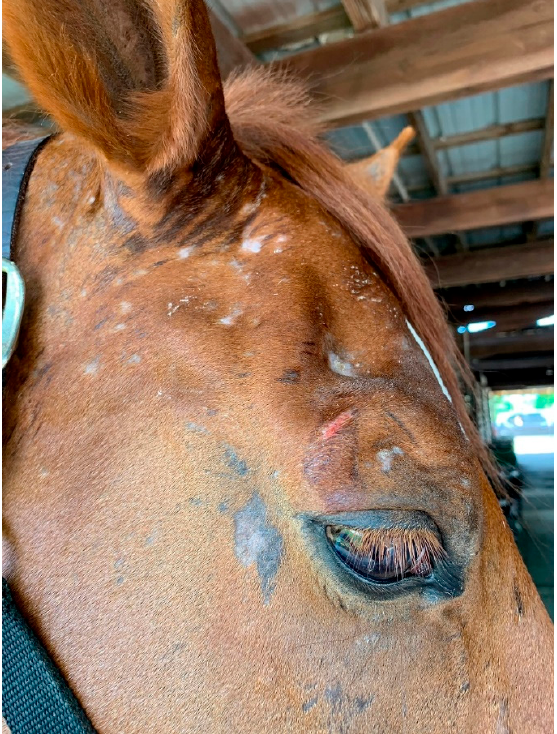
Figure 4. Horse diagnosed with environmental and insect allergies. The pruritus in this patient was intense and led to significant self-trauma. intense and led to significant